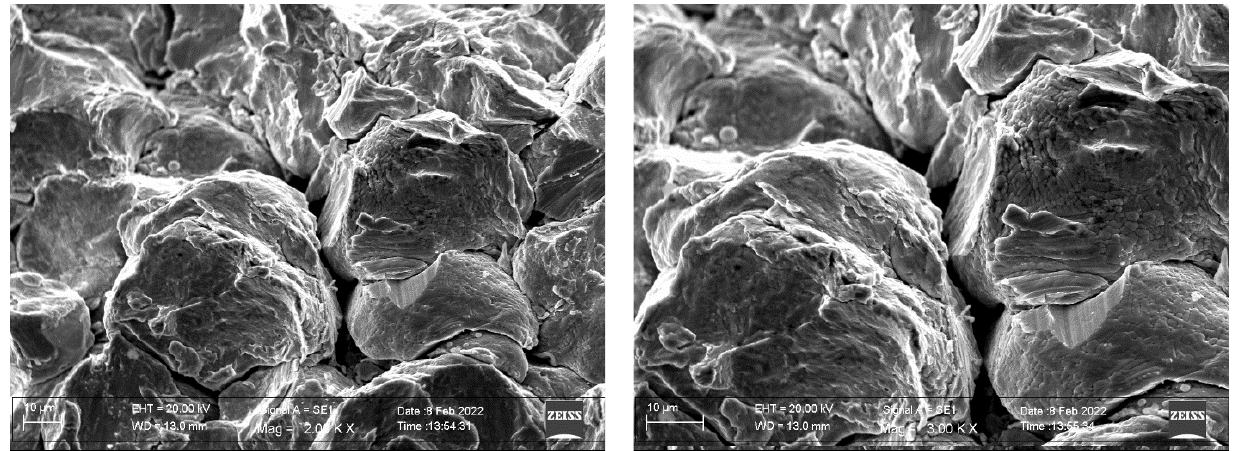
Figure 17. Decohesion at the interfaces of undeformed particles in the samples cyclically bent at the maximum stroke of 1.8 mm.